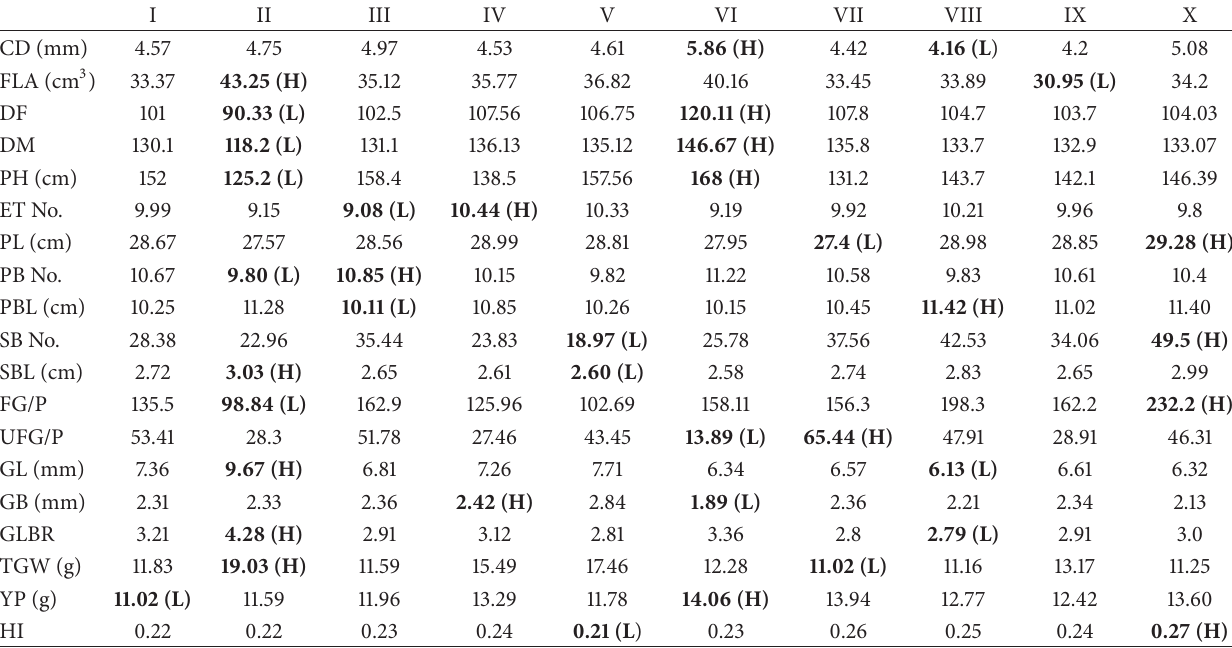
Table 11: Cluster means for 19 quantitative characters in 113 aromatic and fine rice